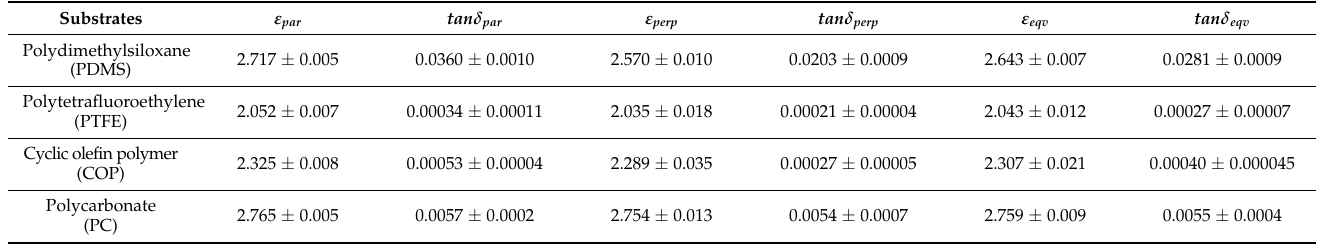
Table 3. Comparison of PDMS dielectric parameters with other similar materials evaluated using the same method.